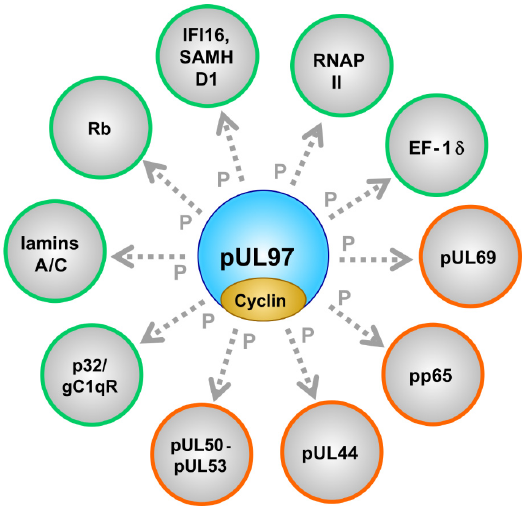
Figure 2. The cytomegalovirus-encoded CDK-like protein kinase pUL97 interacts with cyclins and phosphorylates a number of viral (encircled in orange) and cellular (encircled in green) substrate proteins.